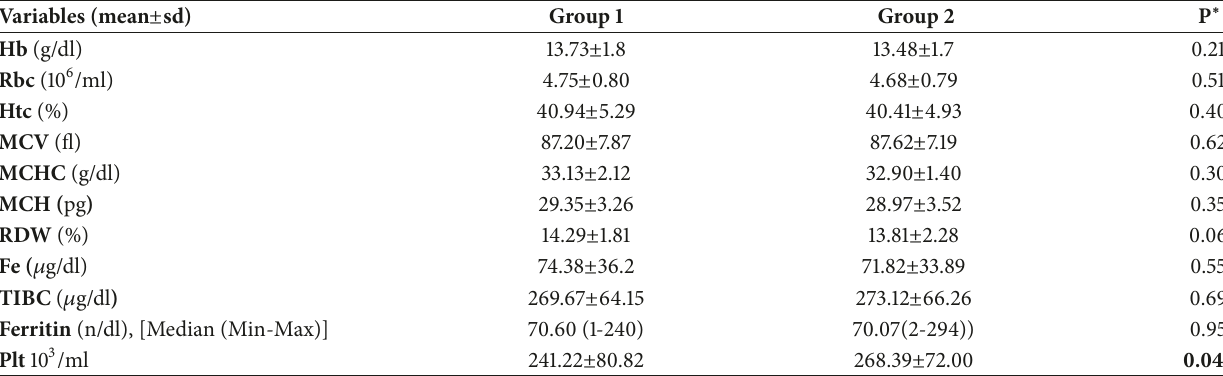
Table 1: Comparisonof Fe, TIBC and ferritin valuesbetween Group 1 and Group 2.